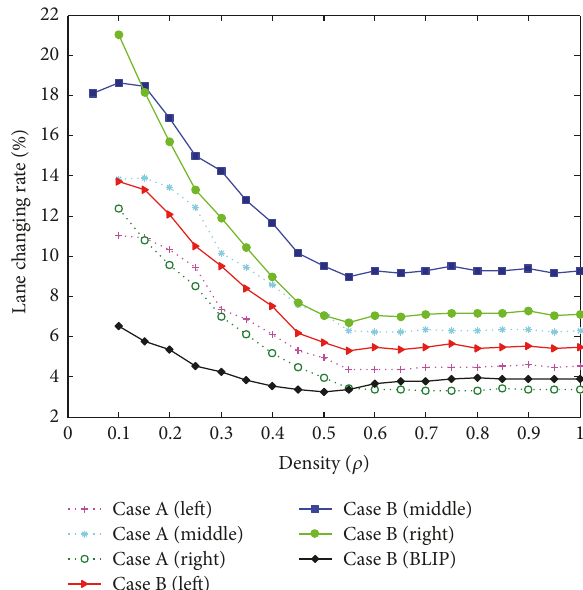
Figure 11: Lane-changing rate of each lane with traffic density increasing in Case A and Case B.